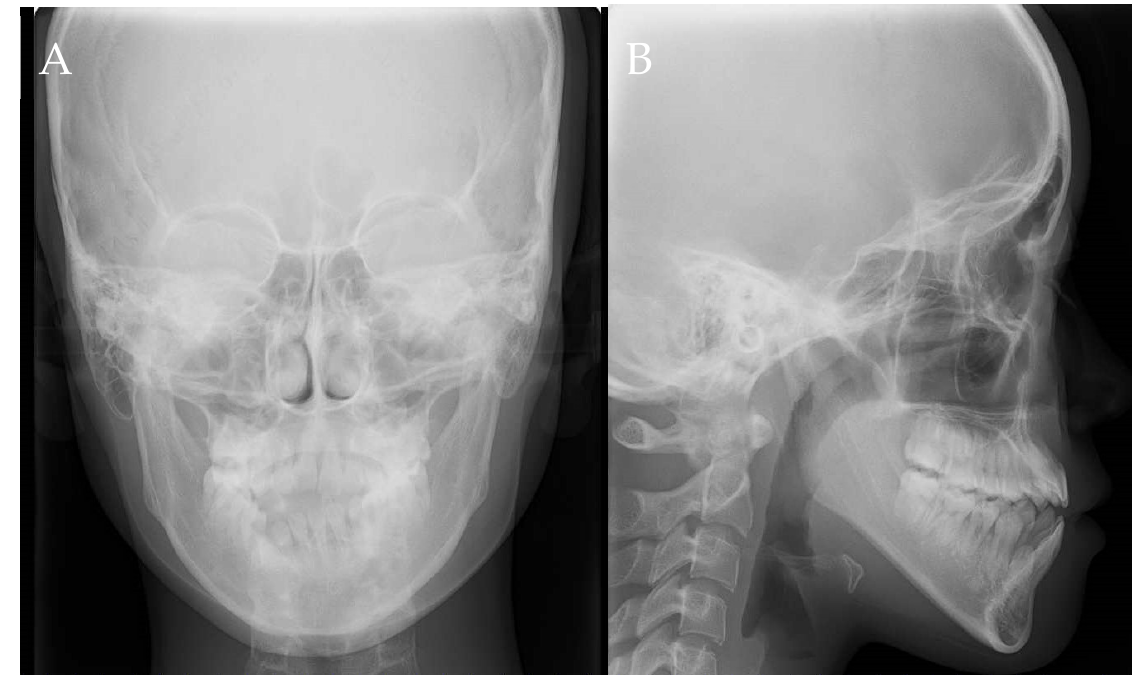
Figure 4. Pre-treatment cephalometric radiograph. ( A ) Front view; ( B ) lateral view. Table 2. Summary of cephalometric measurements.